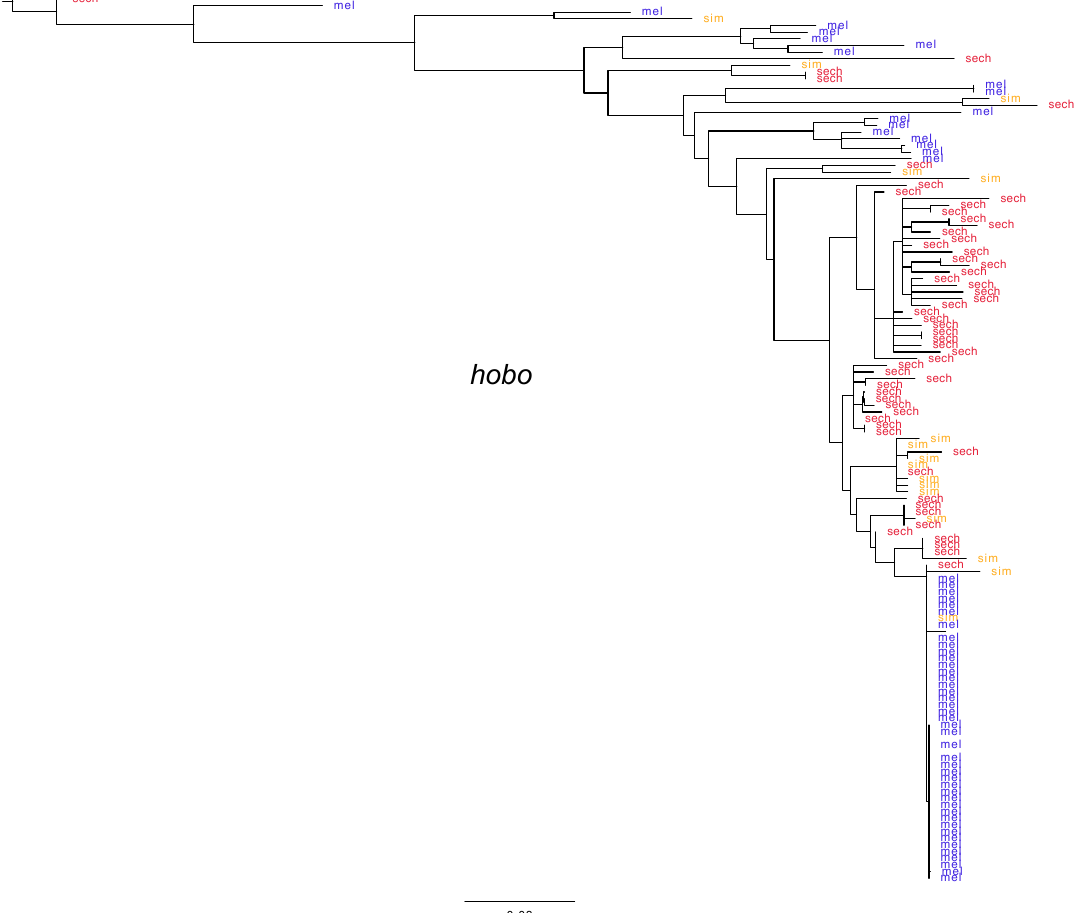
Figure 2. Phylogenetic analysis of hobo element fragments extracted from the genomes of D. melanogaster , D. simulans and D. sechellia . Alignments from BLAST output (E cuto ff − 100) were subjected to phylogenetic analysis with GARLI. Blue indicates D. melanogaster , red indicates D. sechellia and orange indicates D. simulans . The hobo phylogeny shows evidence of a previous wave in D. melanogaster , as well as new proliferation derived from a lineage residing within D. simulans or D. sechellia